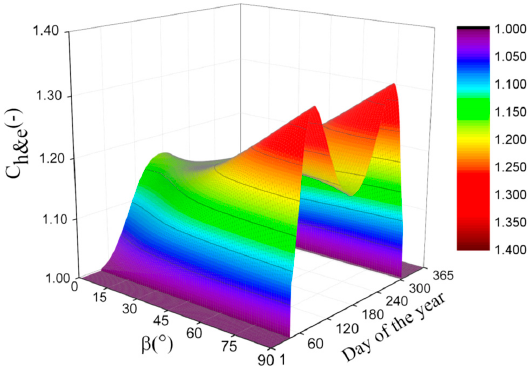
Figure 26. Surface chart of C h & e varying with β and day of the year at 75 ◦ N and ρ = 0.2. Figure 26. Surface chart of 𝐶 (cid:3035)&(cid:3032) varying with 𝛽 and day of the year at 75° N and 𝜌 = 0.2 . Figure 26. Surface chart of 𝐶 (cid:3035)&(cid:3032) varying with 𝛽 and day of the year at 75° N and 𝜌 = 0.2 . Figure 26. Surface chart of 𝐶 (cid:3035)&(cid:3032) varying with 𝛽 and day of the year at 75° N and 𝜌 = 0.2 .